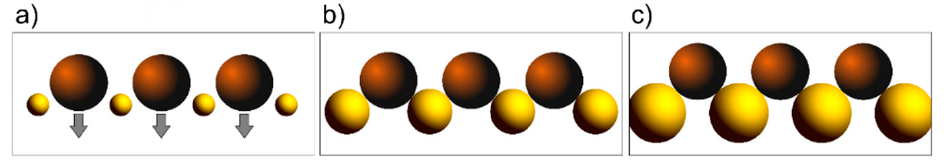
Figure 12. Scheme of movement of solid particles through the emulsion structure at different sizes of emulsion oil droplets: ( a ) small oil droplets, ( b ) medium emulsion oil droplets, and ( c ) large oil droplets.